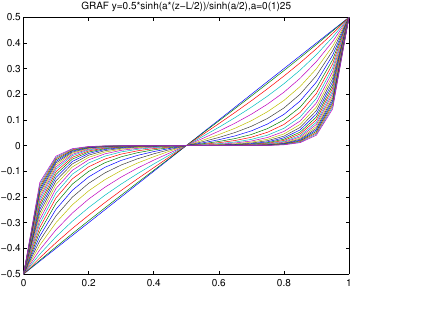
Figure 4. Values of functions f 2 z for hyperbolic spline with a 1 = a 2 ∈ [0 ,